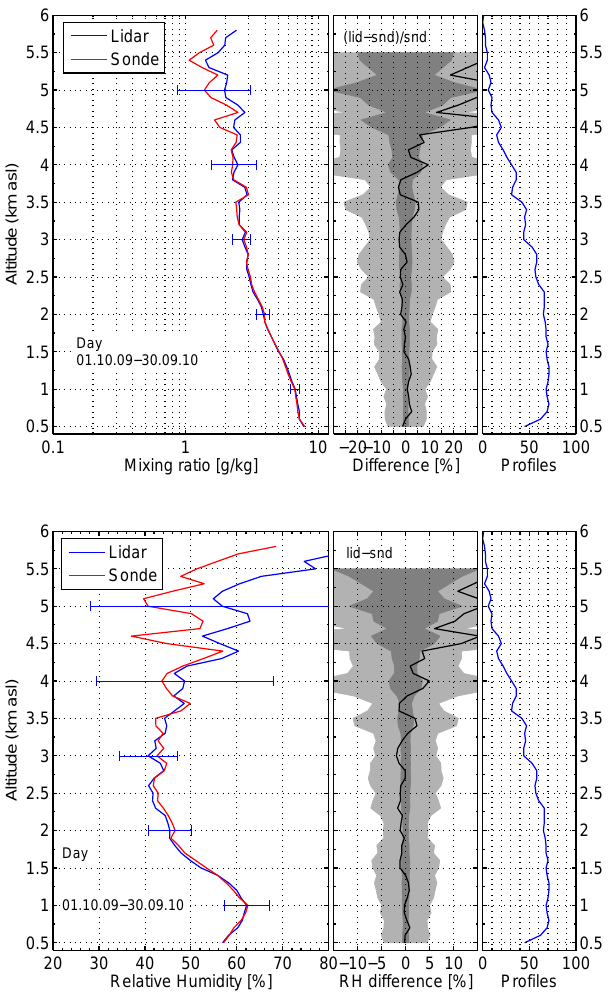
Fig. 8. Top: mean water vapor mixing ratio (left) and mean bias profile (middle) during day. Bottom: mean relative humidity with respect to water (left) and bias profile (middle) during day. Right panels: number of available profiles n . Middle panels: mean value (solid black), standard deviation σ (light grey), error of the mean value ( σ/ √ n , dark grey). Only clear-sky days are considered.